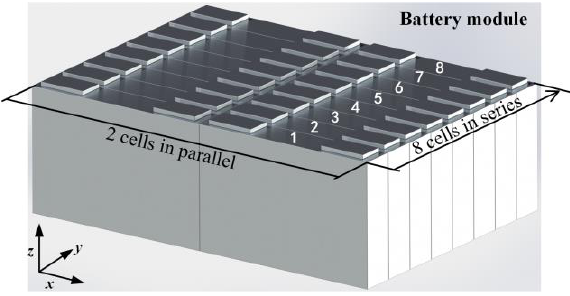
Figure 1. Schematic diagram of lithium-ion battery module.